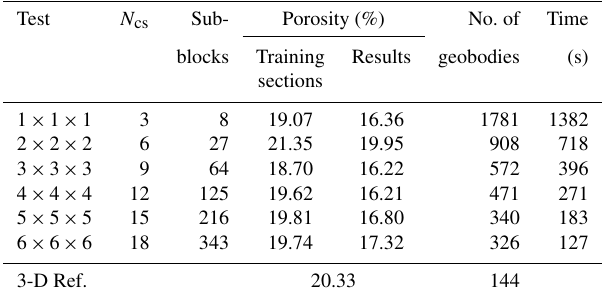
Table 1. Comparison of the performance of the tests in Fig. 5. All the statistics are the averages of 20 realizations.